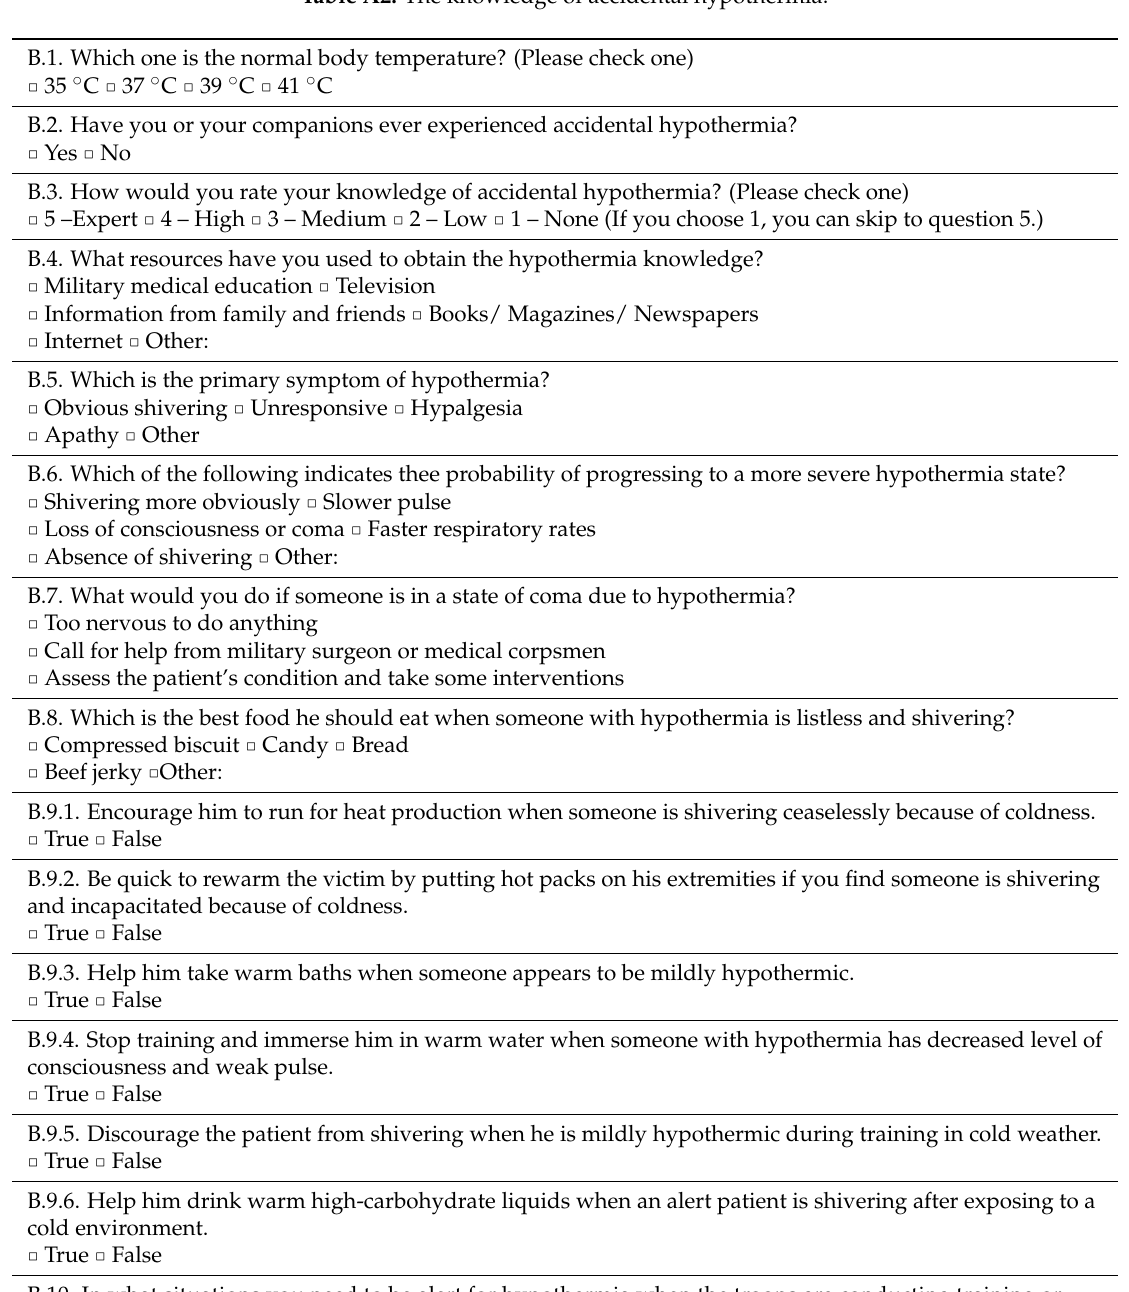
Table A2. The knowledge of accidental